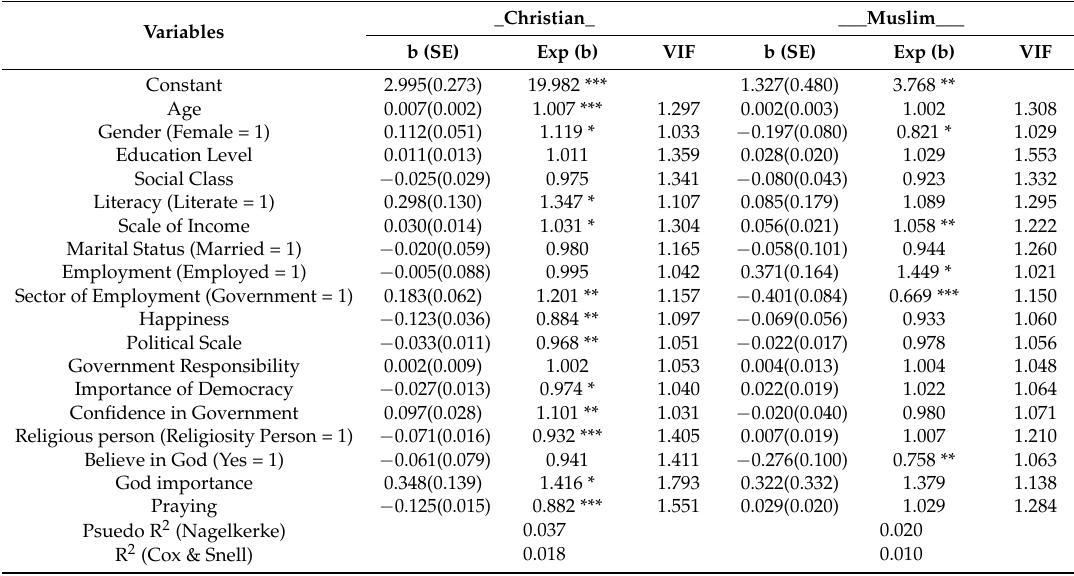
Table 2. Binary Logistic Regression Results for Christian and Muslim